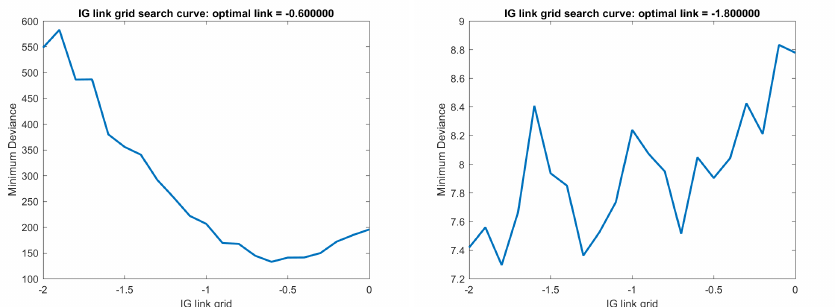
Figure 1. IG GLM LASSO minimum deviance grid search path. ( Left panel ) is a grid search path for the true link function − 0.5; ( Right panel ) is a search path for the true link function − 1.5. The latter rough curve shows that using a grid search of minimum deviance to find the optimal link function is not stable when the true link function is close to the canonical